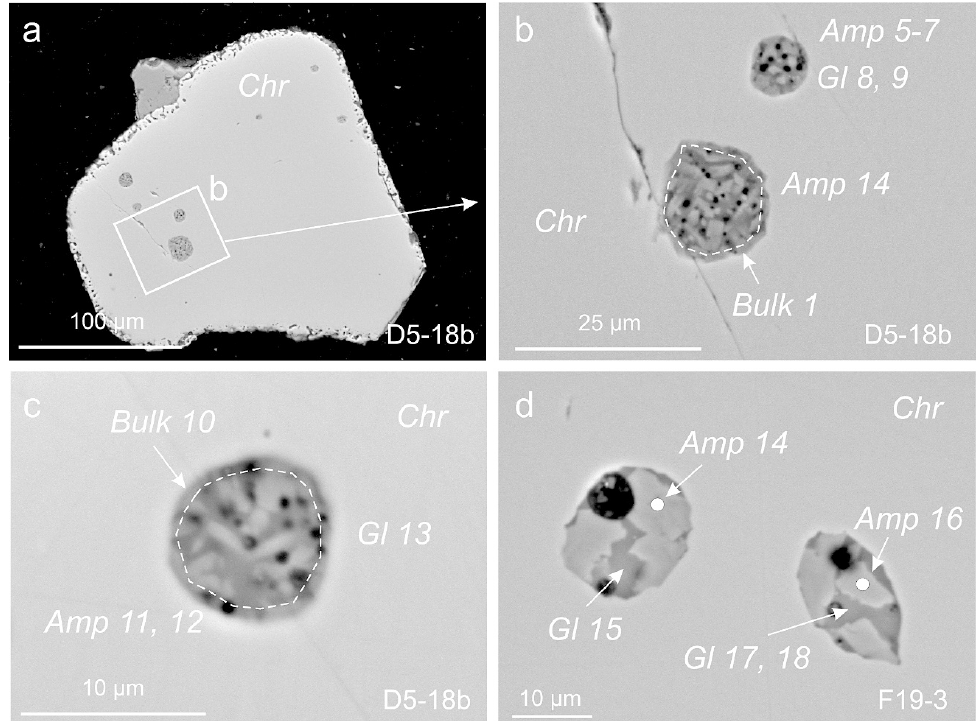
Figure 15. BSE images of melt inclusions in chromites (Chr) from the Sabantuy paleoplacer (samples D 5 -18b, F 19 -3): ( a ) numerous recrystallized melt inclusions in chromite, ( b ) enlarged area of figure ( a ), ( c , d ) recrystallized melt inclusions. Amp—amphibole, Gl—glass, Bulk—area, where the bulk composition of melt inclusions was determined. Note: the numbers indicate the points of the compositions presented in Table 6. Table 6. The bulk composition of melt inclusions, glass and constituent amphiboles (wt.%). Sample D 5 -18b